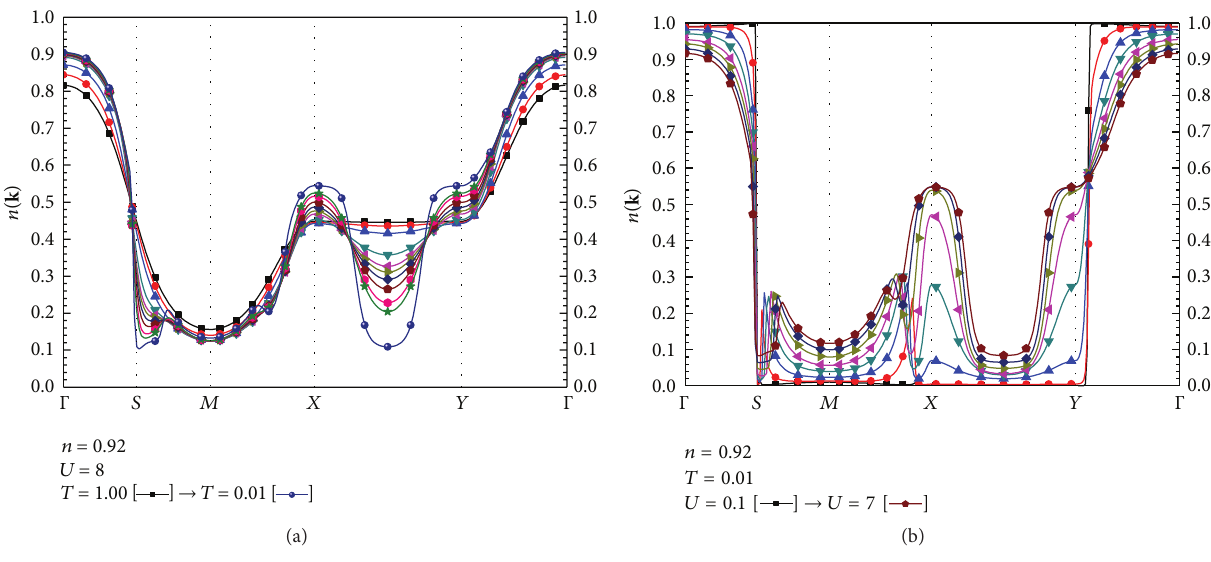
Figure 9: (Color online) The momentum distribution function 𝑛( k ) along the main directions ( Γ = (0,0) → 𝑀 = (𝜋,𝜋) → 𝑋 = (𝜋,0) → 𝑌 = (0,𝜋) → Γ = (0, 0) ) for different values of temperature 𝑇 (a) and on-site Coulomb repulsion 𝑈 (b) at 𝑛 = 0.92 .